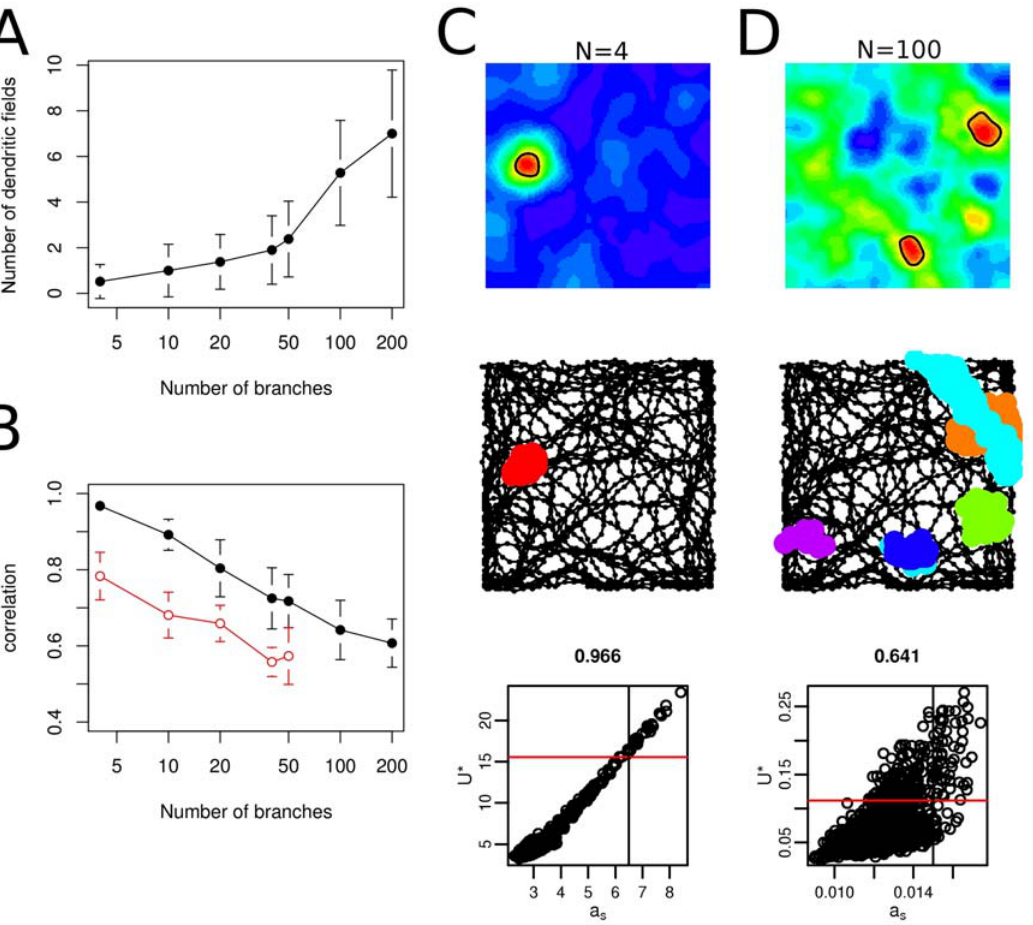
Figure 7. Spatial firing patterns with different number of dendritic subunits. (A) The number of dendritic place fields increases with the number of subunits although the probability of learning were kept constant. (B) The correlation between the somatic activity ( a s ) and the maximal input ( U * ) decreases if the number of dendritic subunits increases. Open circles: correlation in the absence of dendritic spikes. Error bars on A and B show the standard deviation of 50 trials in 5 different environment. (C–D) Spatial firing patterns with N =4 (C) and N =100 (D) dendritic subunits. Upper and middle row is the same as on Figure 6. Lower row: scatter plot showing the joint distribution of the somatic activation a s and the maximal dendritic input U * . Threshold for synaptic plasticity in the branches (horizontal line) and somatic firing (vertical line) are indicated. The correlation between the two variables is shown above the panels. If the neuron has a small number of dendritic subunits than the number of dendritic fields is small (A, C) but they propagate efficiently to the soma. Conversely, a neuron with a large number of dendritic subunits might have numerous dendritic fields, but the individual dendritic spikes have a little impact on the somatic activation.